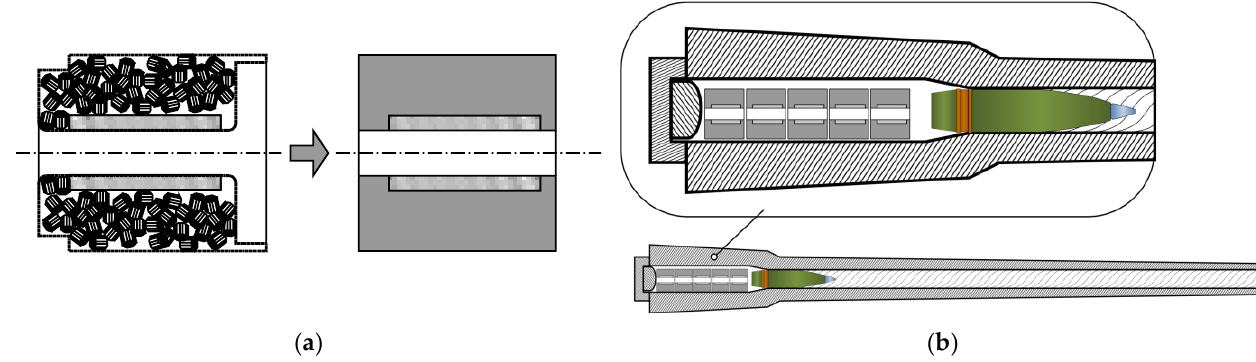
Figure 6. Modular charge geometry modeling: ( a ) outline of module assembly and simplification of geometry for 3D modeling; ( b ) representation of MACS loaded in 155 mm/39 gun chamber.